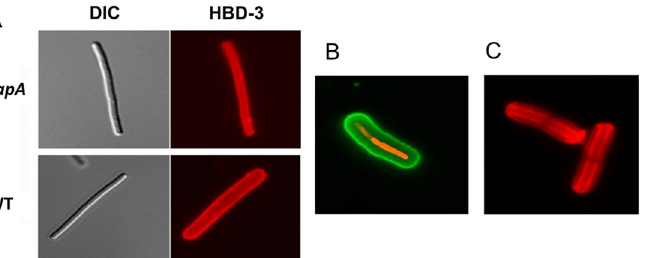
Fig 5. Detection of HBD-3 binding to B . anthracis bacilli. (A) Non-encapsulated capA mutant (upper quadrants) or encapsulated WT (lower quadrants) bacilli were incubated with 5 ug HBD-3. Left panels show differential interference contrast (DIC) microscopy images. Right panels show fluorescence microscopy images. HBD-3 binding was detected using rabbit anti-HBD-3 and AF594 conjugated goat anti-rabbit IgG antibody (red, magnification x 1,000). (B) Encapsulated WT bacilli were incubated with 5 ug Atto-594-labeled HBD-3 (red). Capsule was detected with FITC- labeled anti-capsule mAb (green). Magnification x 1,000. (C) Encapsulated WT bacilli were incubated with 20 ug Atto- 594-labeled HBD-3. Magnification x